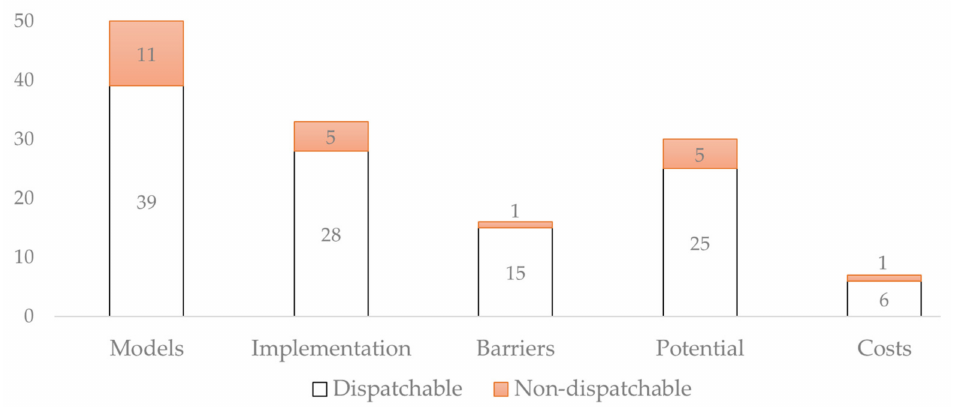
Figure 9. Distribution of the selected references according to the different areas of demand